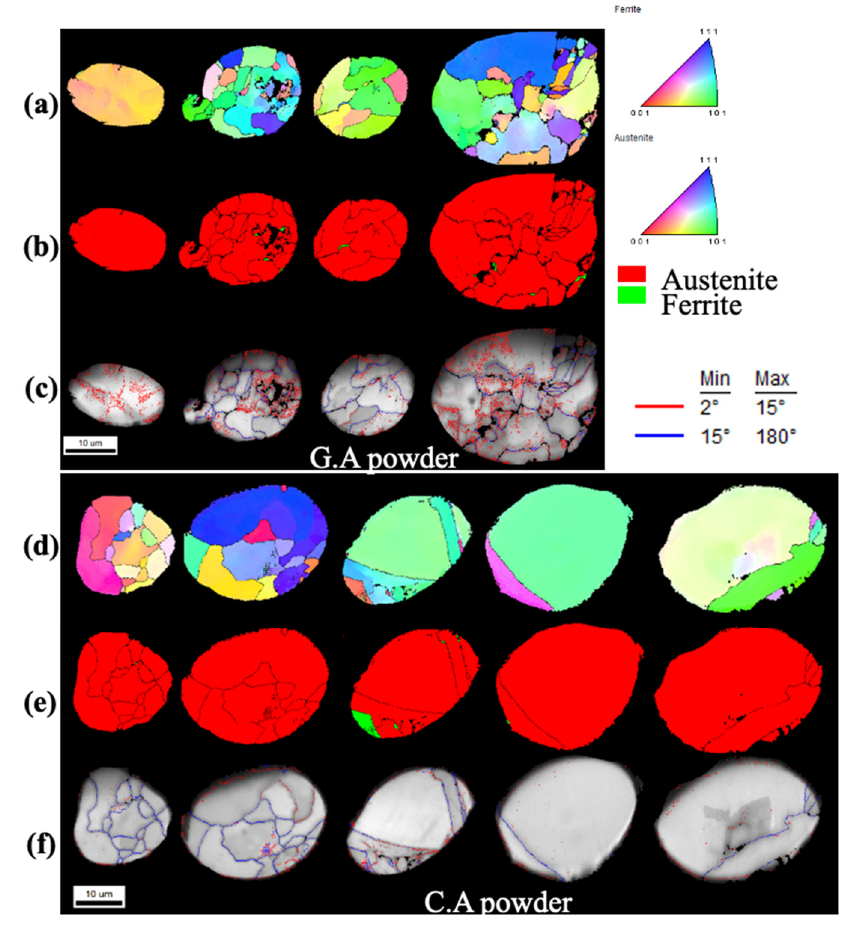
Figure 8. EBSD data IPF ( a , d ); phase map ( b , e ); IQ map with red (>2°, <15°) LAGBs and blue HAGBs (>15°) ( c , f ) for G.A and C.A powders, respectively.